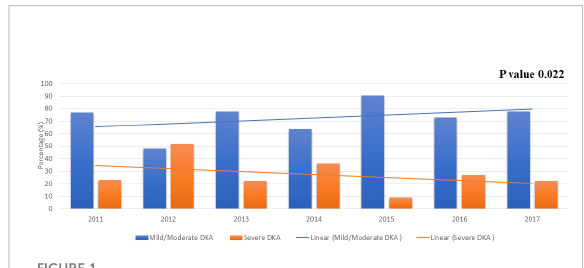
FIGURE 1 The severity of DKA over the years in children newly diagnosed with T1D older than 6 years of age. .